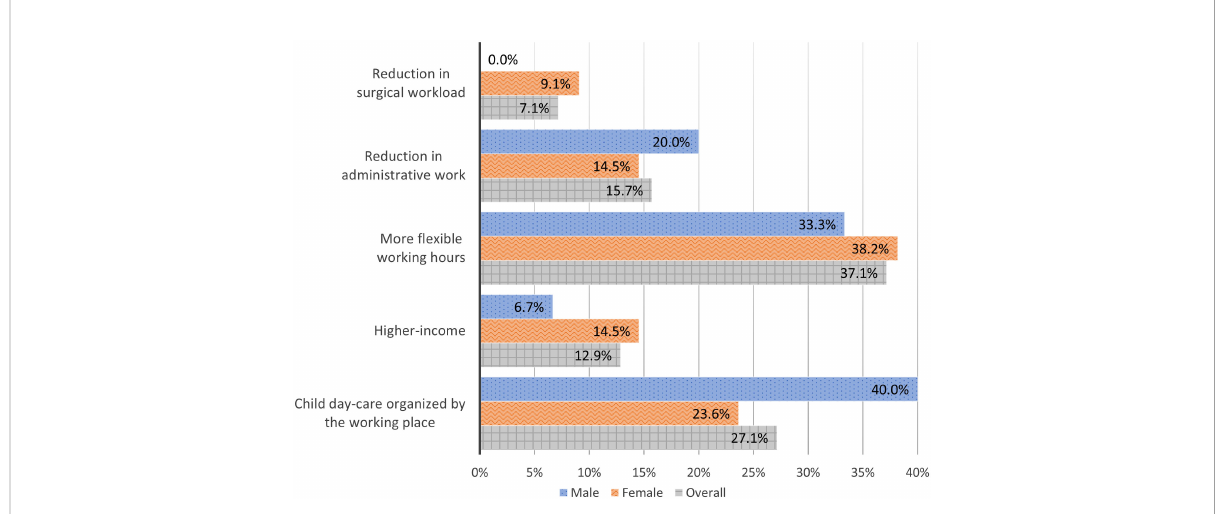
FIGURE 3 Suggested ways to increase the feasibility for a woman to be both a successful gynecologic oncology surgeon and a caring